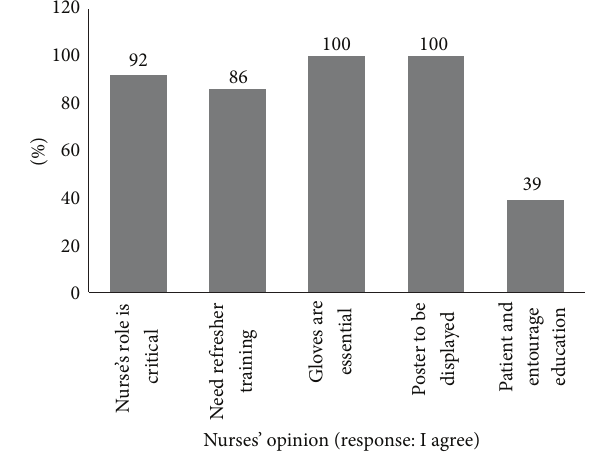
Figure 1: Nurses’ attitudes towards healthcare waste